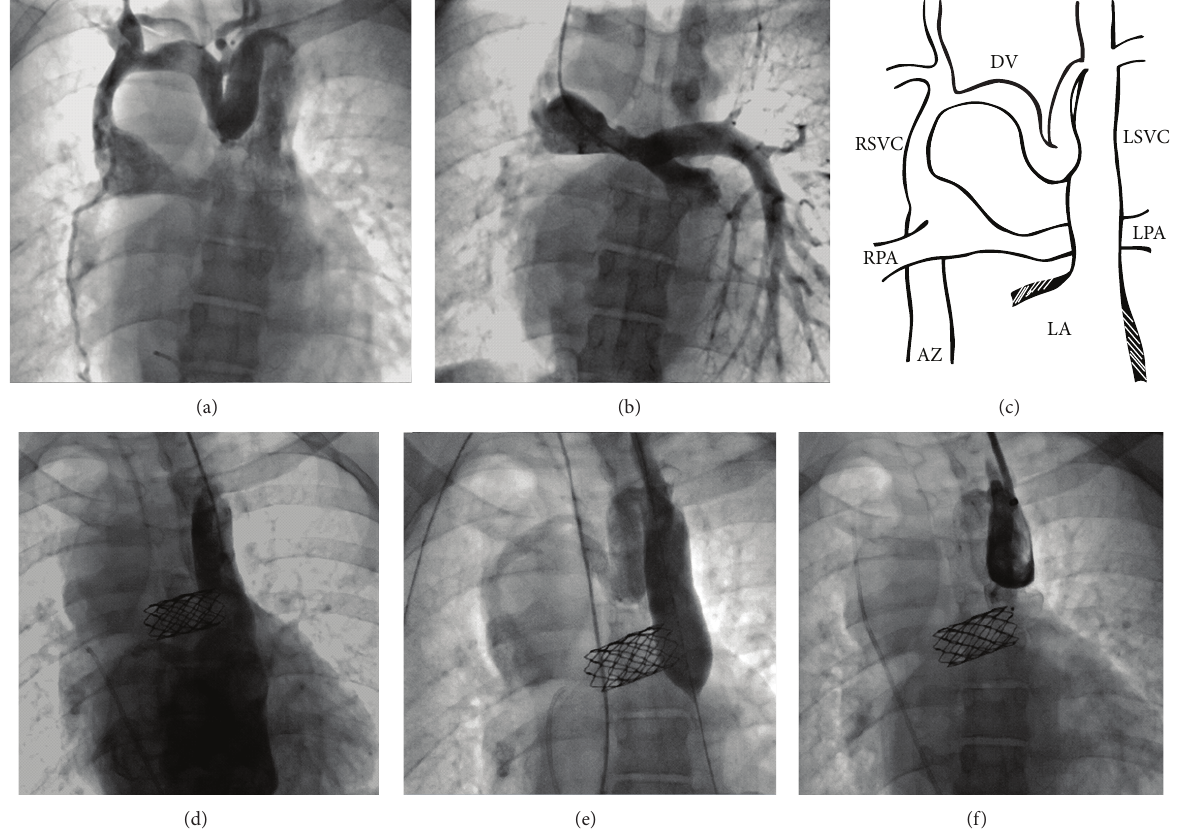
Figure 1: Vein angiography in a 35-year-old patient with univentricular heart 18 years following Kawashima operation. (a) Angiography through right internal jugular vein shows flow from the right superior caval vein to the left superior caval vein via a tortuous decompressing vein. (b) Angiography of the pulmonary artery shows mild narrowing of the left pulmonary artery. (c) Schematic of the venous anatomy. (d) During a separate procedure after stent placement in the left pulmonary artery, angiography through left jugular vein showing the large left superior caval draining to the left atrium. (e) Angiography during balloon test occlusion. (f) Angiography following device closure showing residual leak. (AZ: azygous vein, DV: decompressing vein, LA: left atrium, LPA: left pulmonary artery, LSVC: left superior caval vein, RPA: right pulmonary artery, and RSVC: right superior caval